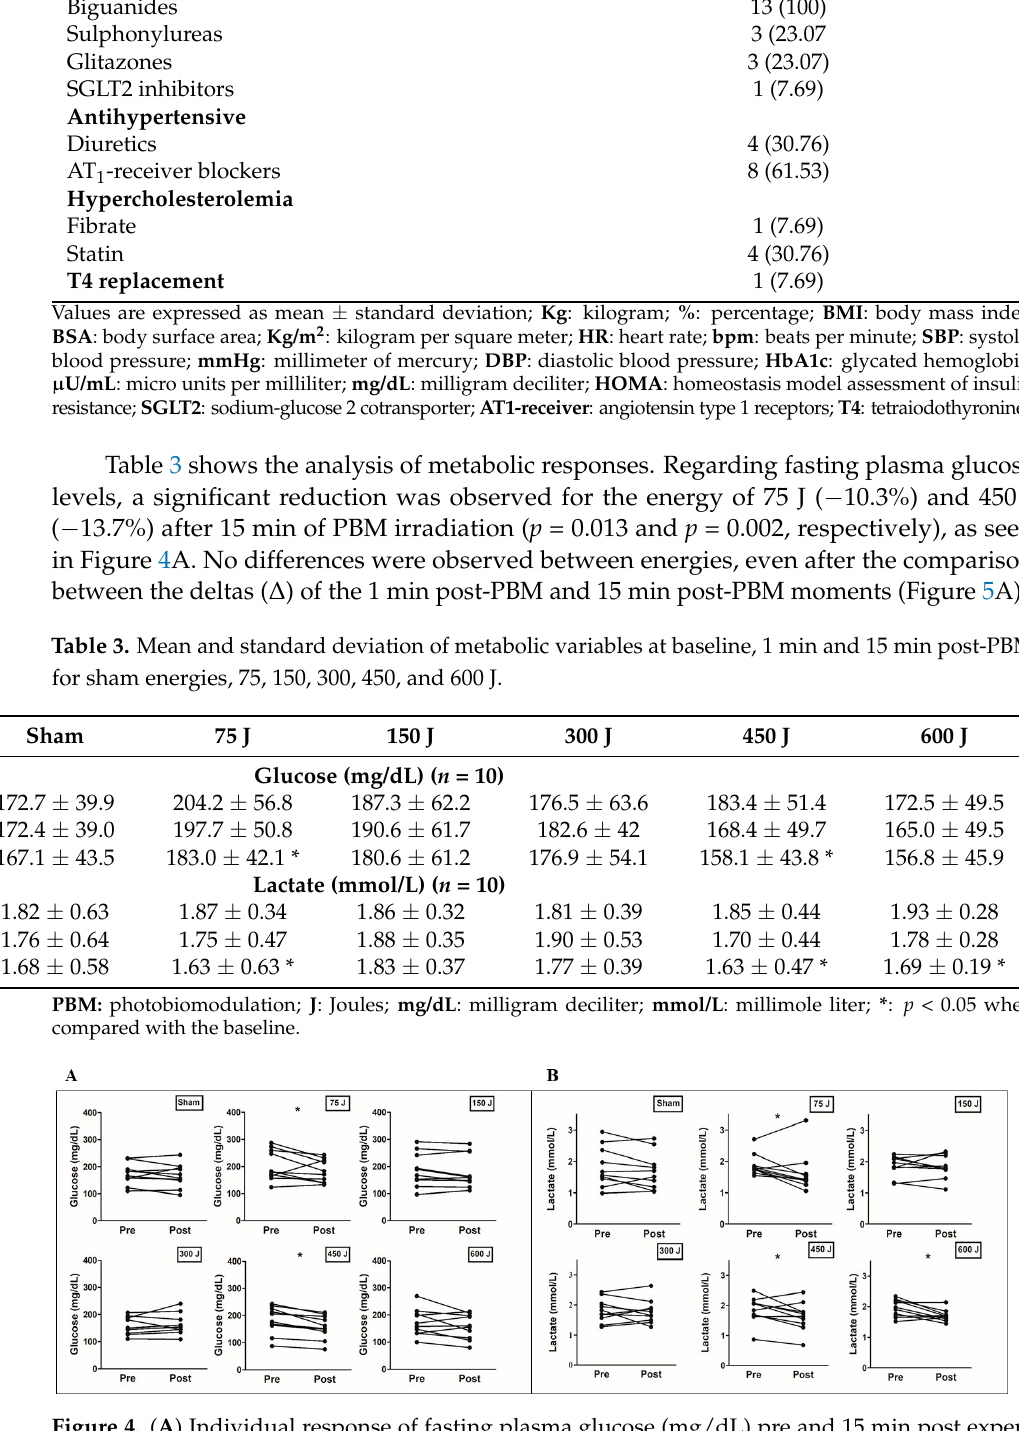
Figure 4. ( A ) Individual response of fasting plasma glucose (mg/dL) pre and 15 min post experi- mental protocol for each energy, sham, 75, 150, 300, 450, and 600 J. ( B ) Individual response of lactate (mmol/L) pre and 15 min post experimental protocol for each energy, sham, 75, 150, 300, 450, and 600 J. *: p < 0.05 when compared to the baseline. Table 4 shows the changes in 𝑄(cid:4662) compared to different energies and moments. For the energy of 75 J, a significant increase was observed after 1 min ( p = 0.002) of PBM irra- diation, with maintenance after 15 min ( p = 0.015). For the energy of 300 J, we observed a significant increase after 1 min ( p < 0.001). However, there was a reduction in 𝑄(cid:4662) after 15 min ( p = 0.007). The same behavior is seen in CI. Furthermore, when comparing the ∆ of the effective and sham energies at moment 1 min post-PBM, we observed a difference between the energies 75 J vs 600 J ( p = 0.010) and 300 J vs 600 J ( p = 0.005). The same differ- ences were observed at the ∆ 𝑄(cid:4662) and in the ∆ CI at the moment 15 min post PBM ( p = 0.007, and p = 0.029, respectively), as seen in Figure 5C,D.